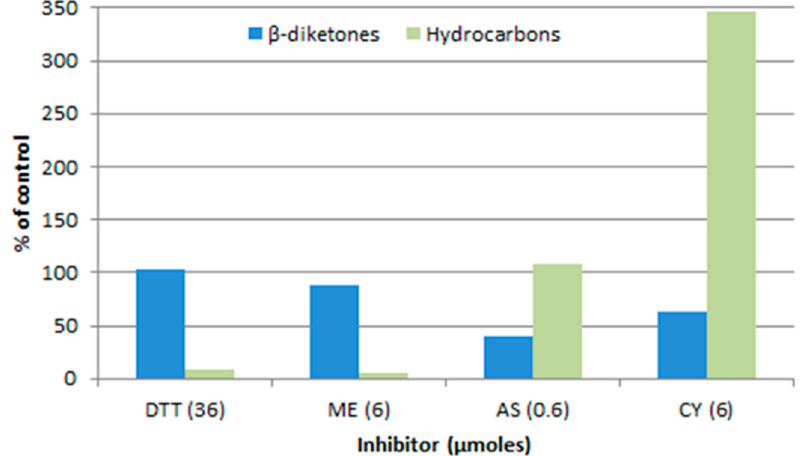
Figure 7. Preincubation with inhibitors affects the amount of label incorporated into the β -diketones and hydrocarbons of cer-u.69 spike wax from [2- 14 C]-acetate [37]. DTT, 1,4-dithiothreitol; ME, 2-mercaptoethanol; AS, sodium arsenite; CY, potassium cyanide.